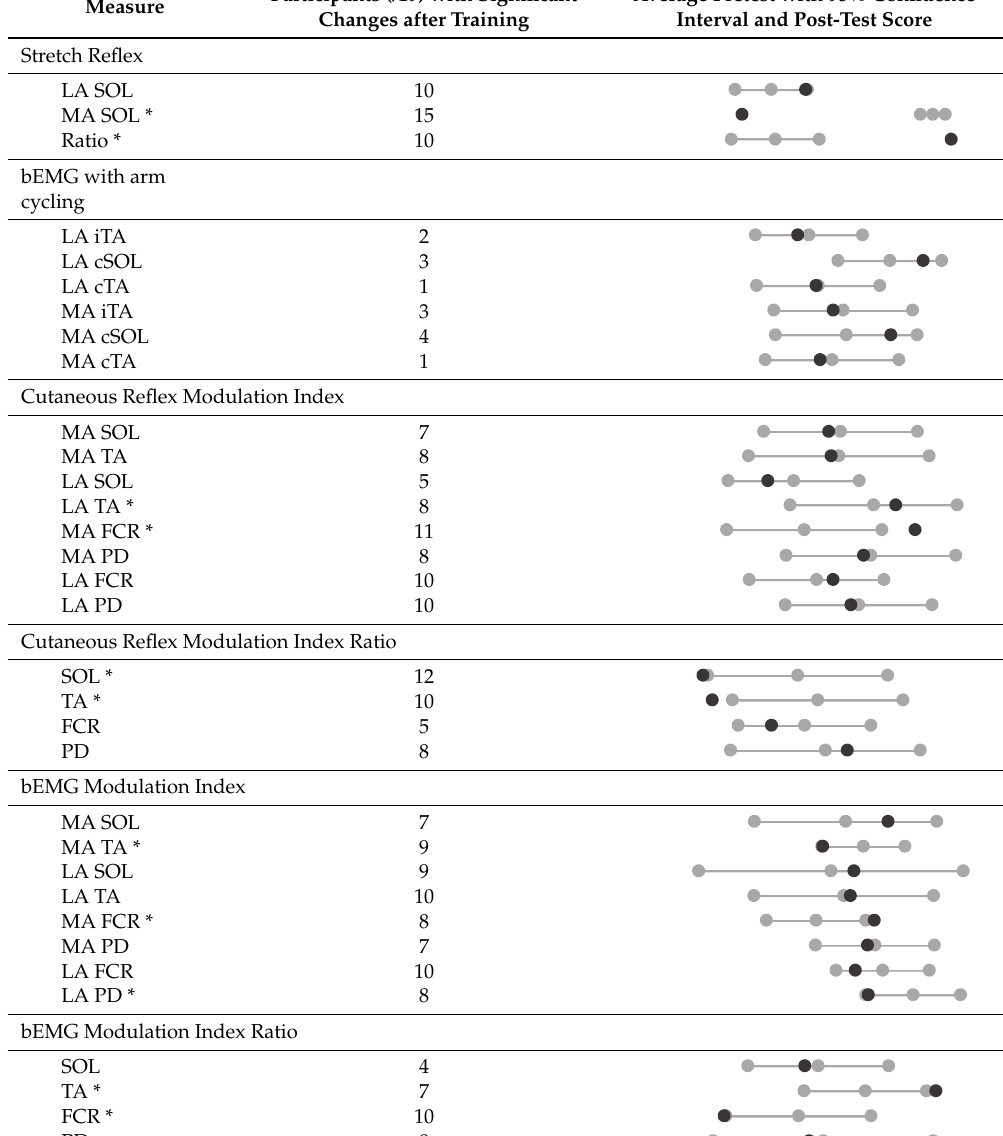
Table 2. Summary of results from within-subject analyses.